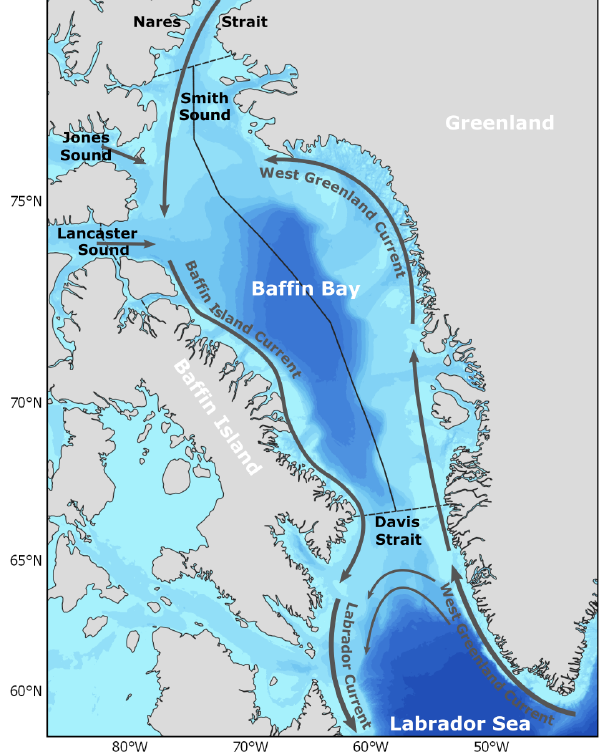
Figure 1. Schematic of the ocean currents and bathymetry of Baffin Bay separated in sections western Baffin Bay and eastern Baffin Bay. Bathymetry data from the GEBCO grid (GEBCO Compilation Group,